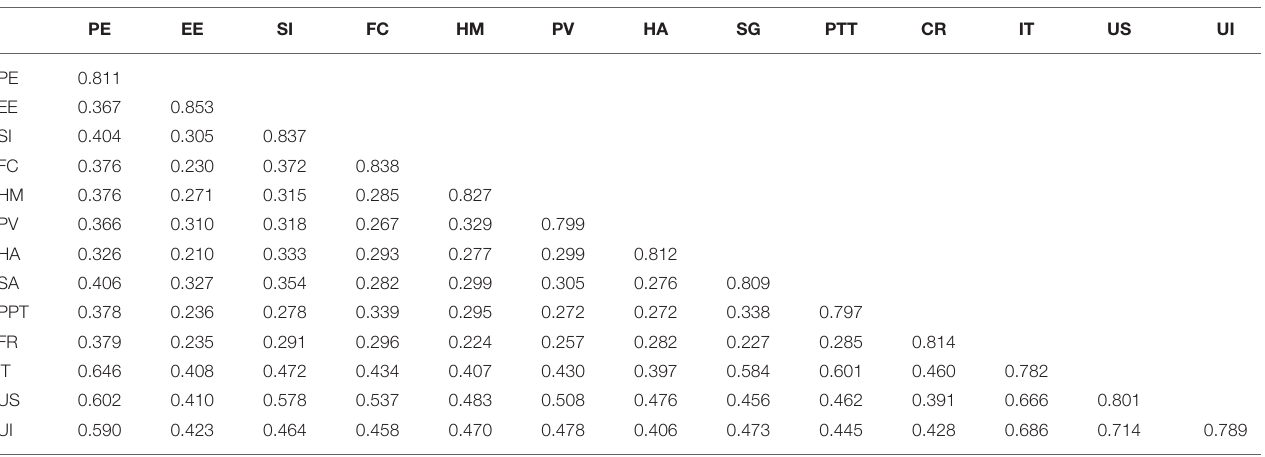
TABLE 3 | Discriminant validity (entire